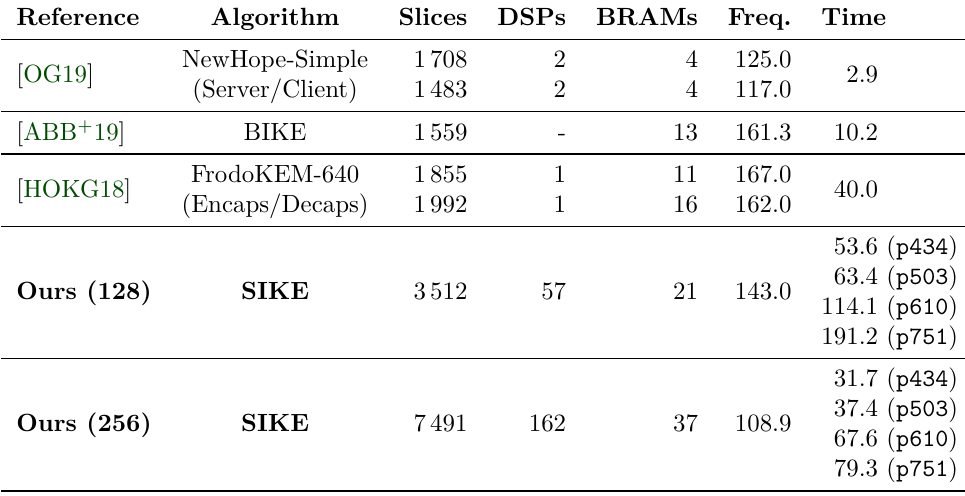
Table 5: Comparison of PQC implementations on the Xilinx Artix 7 100T. The frequency (“Freq.”) is measured in Megahertz (MHz), the total time ( Encaps + Decaps for BIKE, FrodoKEM and SIKE, a full ephemeral key exchange for NewHope) in milliseconds (ms). Our architecture works directly for any parameter set pXXX for XXX ∈ { 434 , 503 , 610 , 751 } and does not need to be